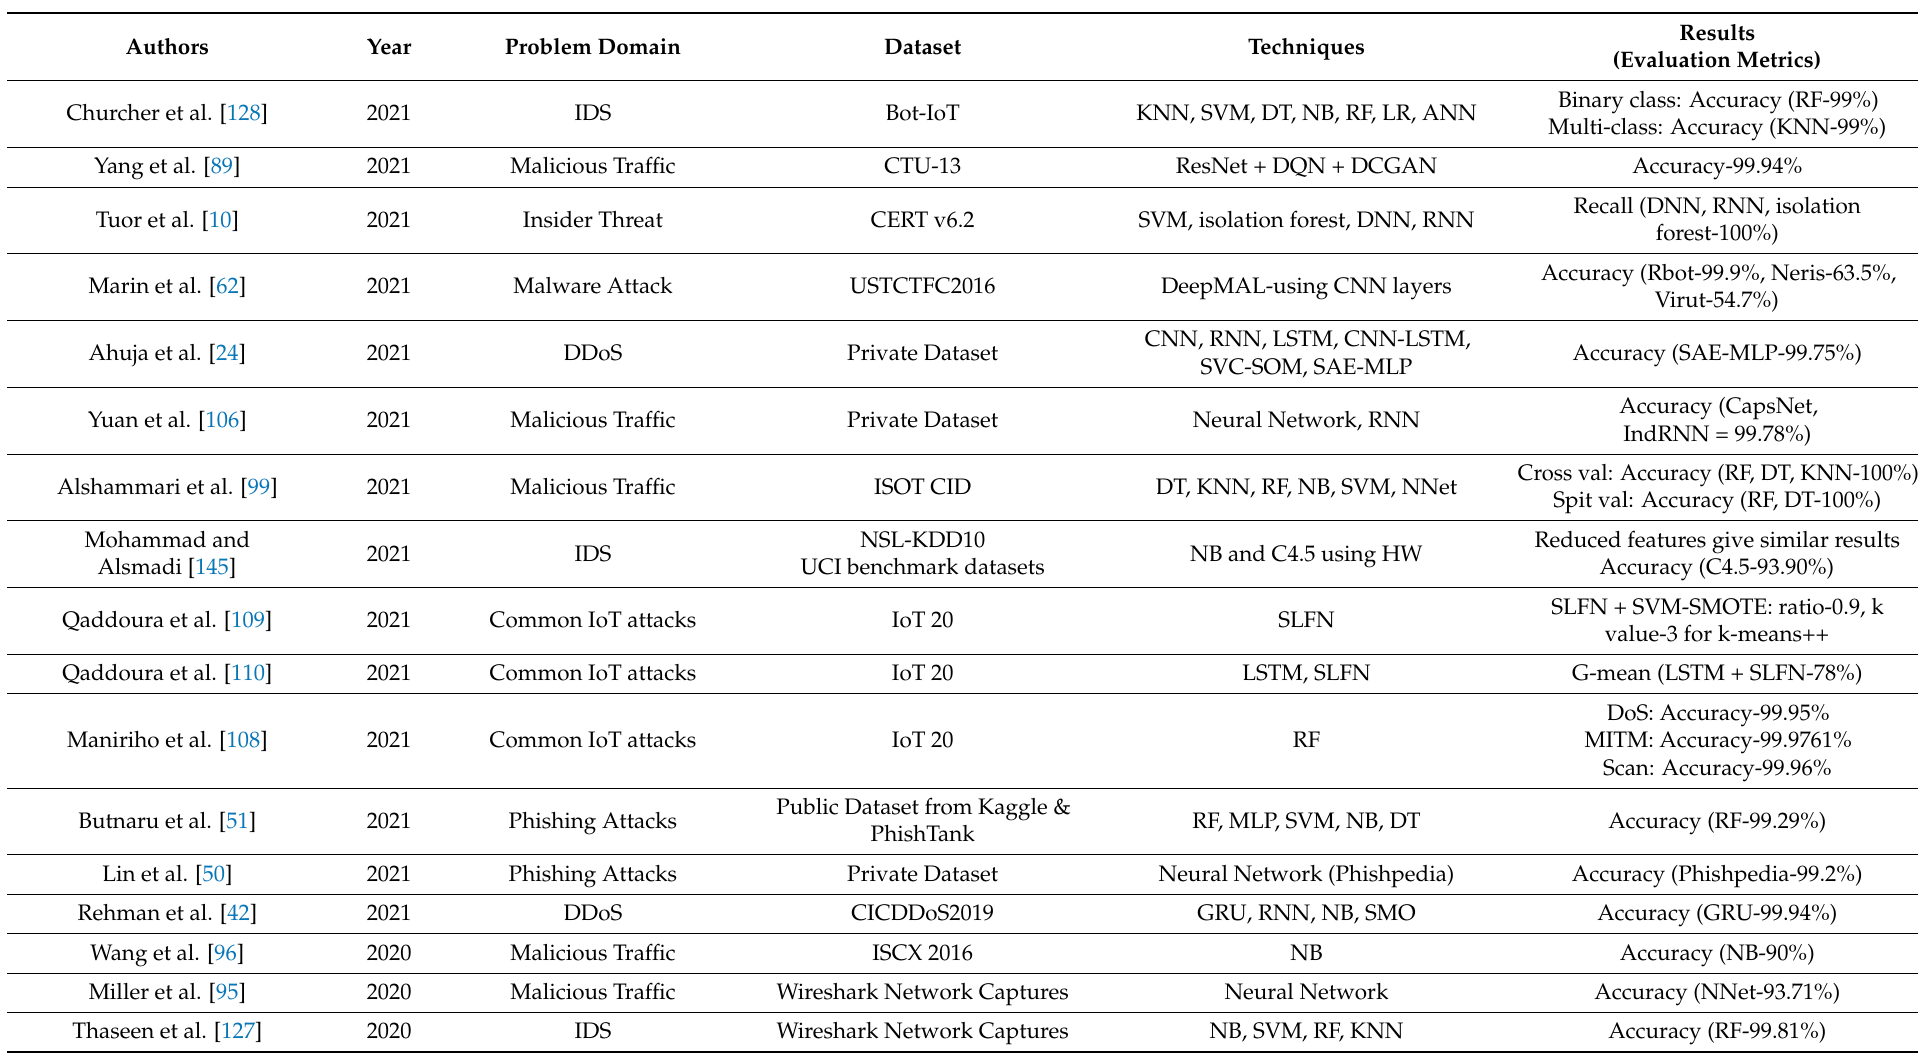
Table 2. Brief summaries of the reviewed